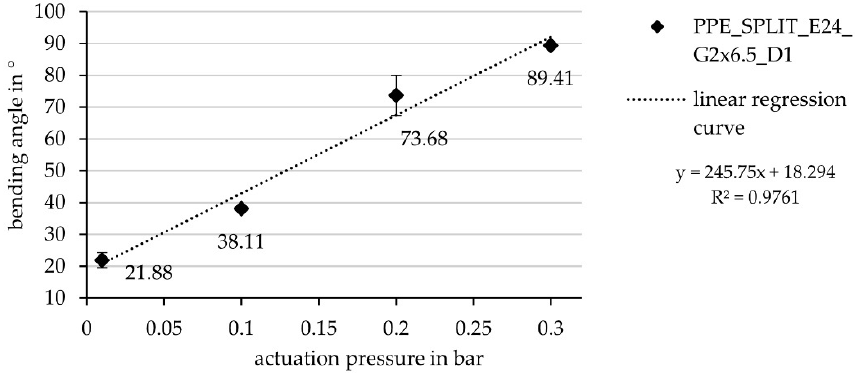
Figure 16. Bending angle as a function of the actuation pressure for the hinge component with two cushions (width per hinge 6.5 cm; distance between hinges 1 cm).